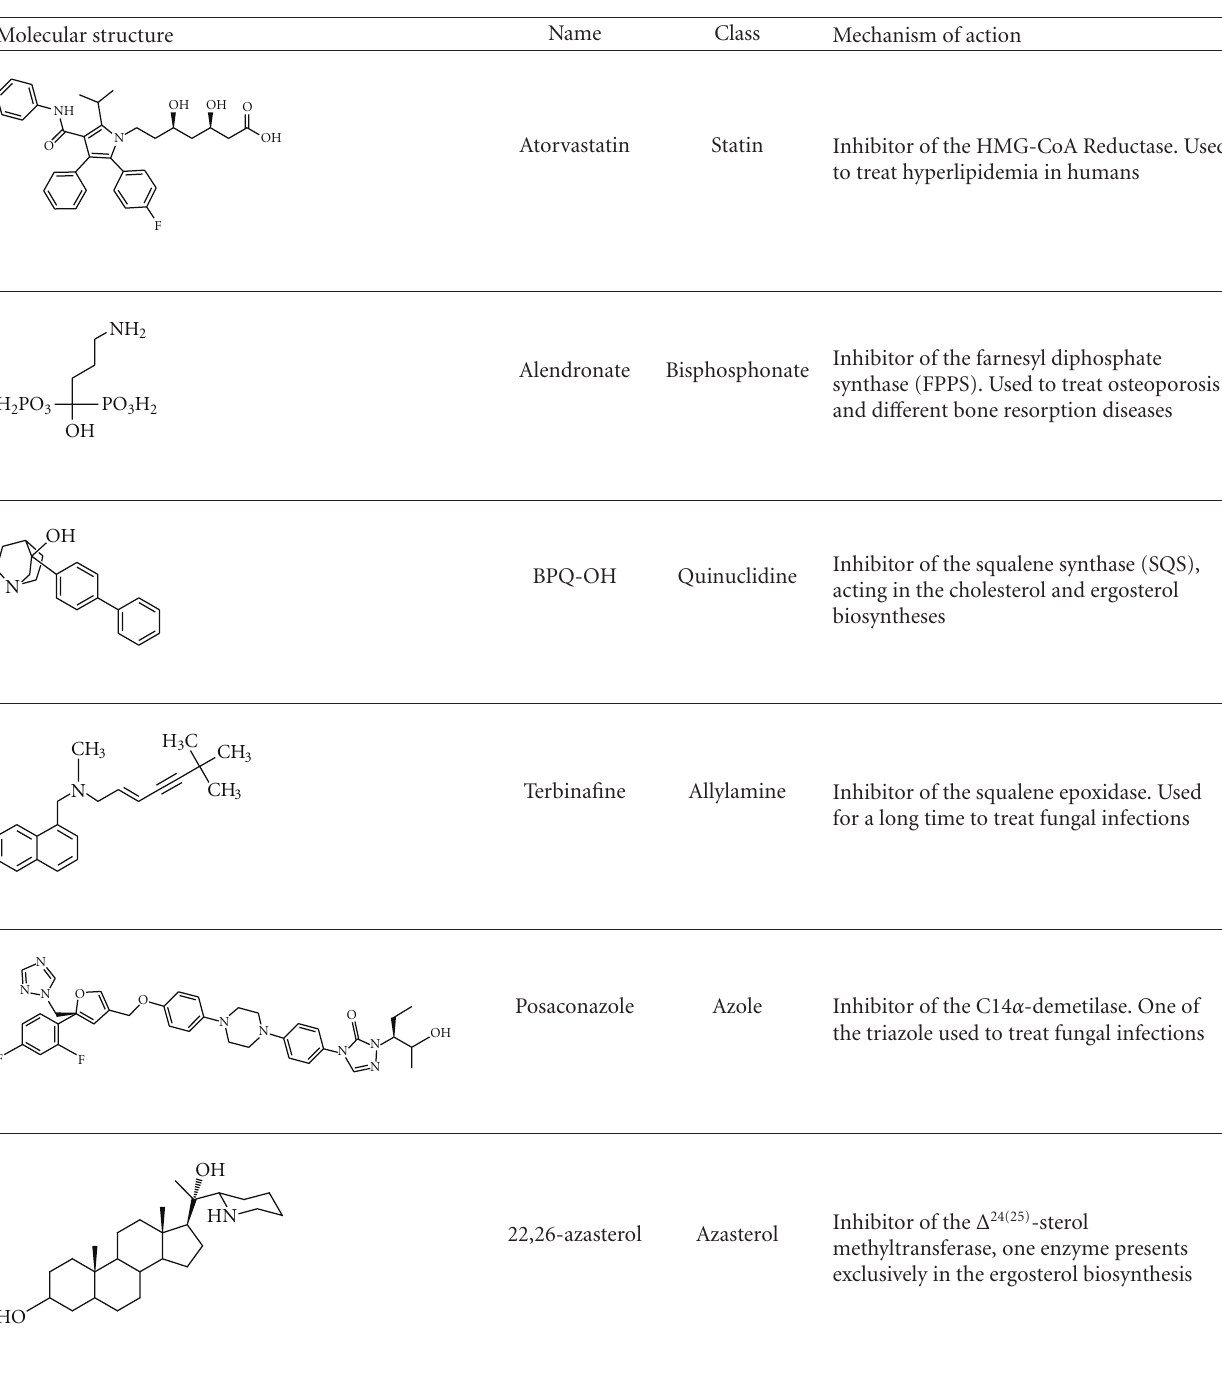
Table 1: Representative compounds that interfere with sterol synthesis in eukaryotes, fungi and trypanosomatids. Molecular